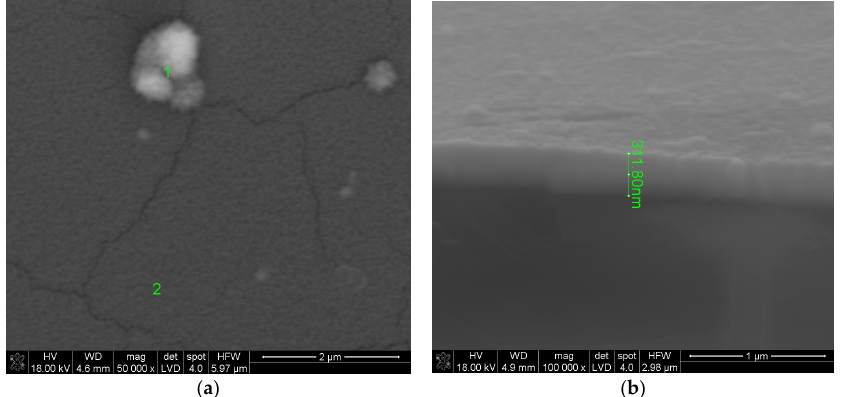
Figure 1. Surface ( a ) and cross-section ( b ) of the ZrO 2 -Sm 2 O 3 layer synthesized using 22.75 mol.%. Sm(tmhd) 3 at about 550 °C. Static gas pressure: around 6.6 × 10 3 Pa. Synthesis time: 20 min.